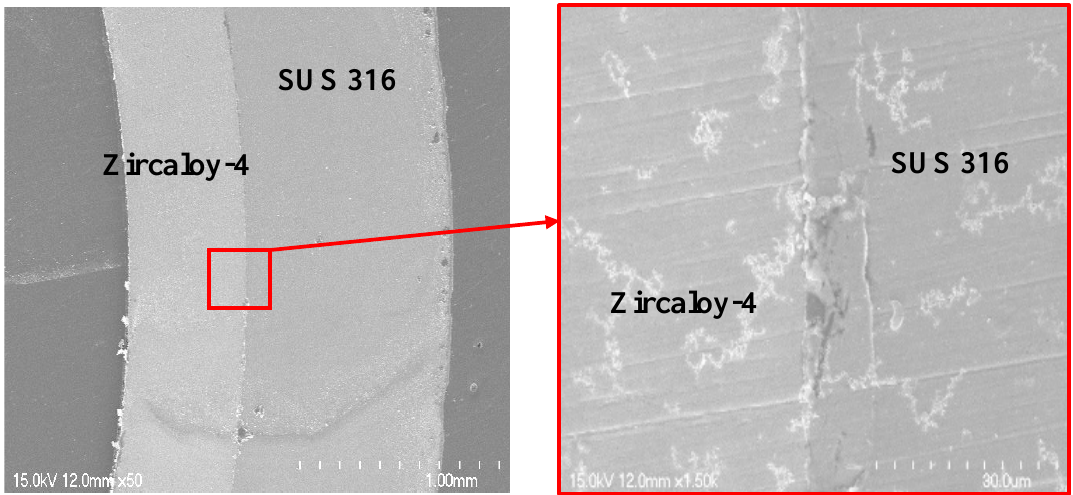
Figure 6. Secondary electron microscope image of the PST interface without heat treatment.